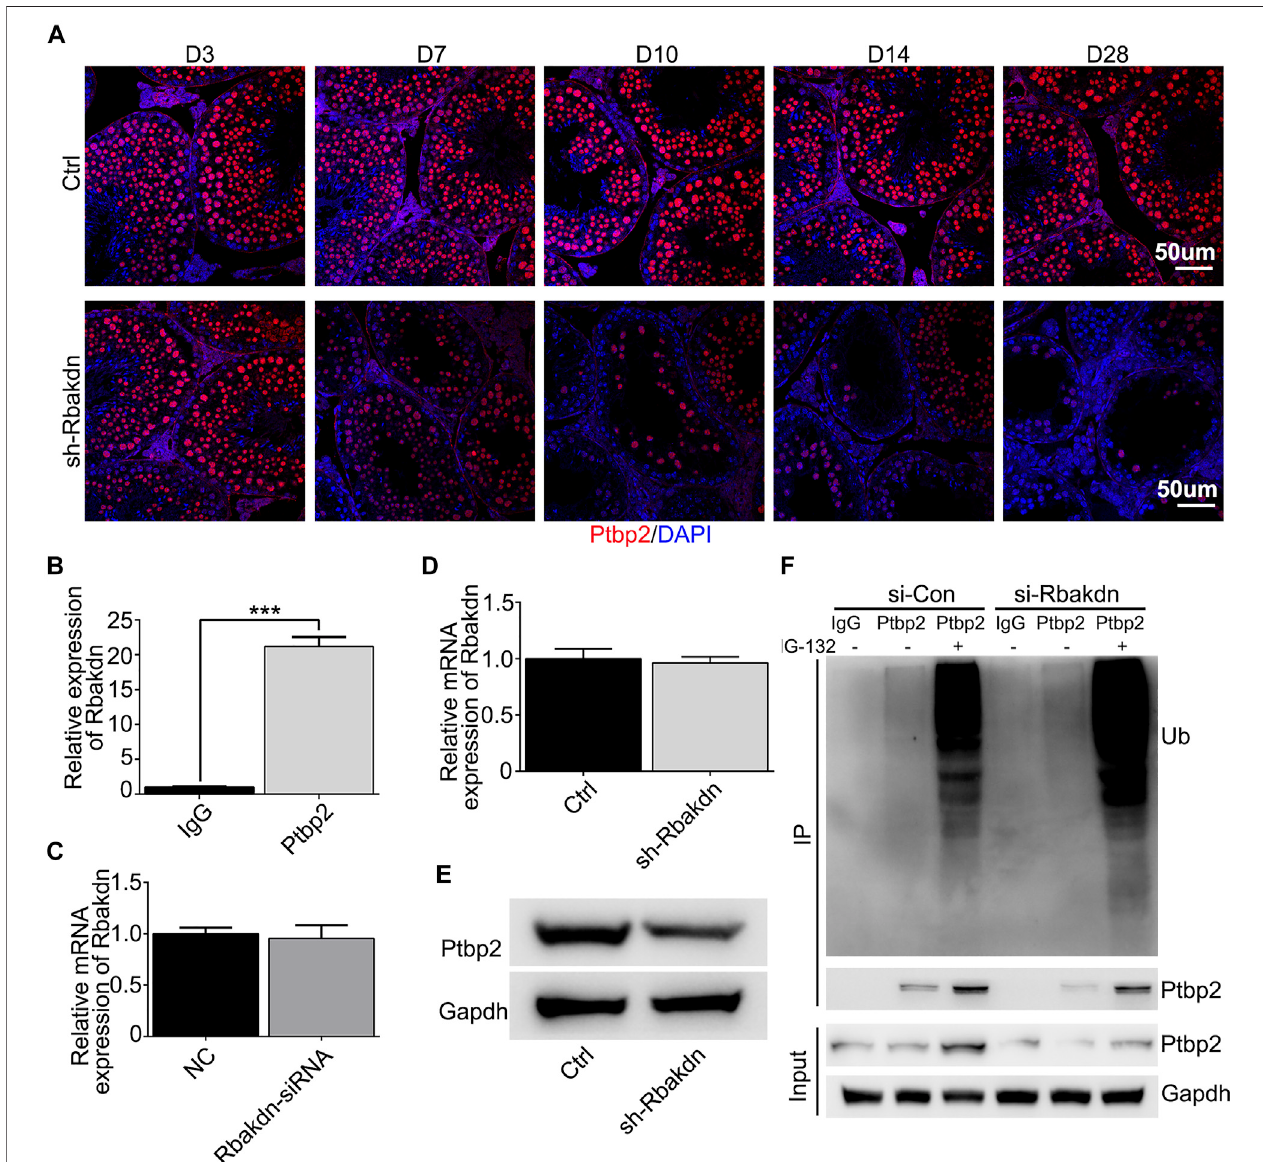
FIGURE 5 | Knockdown of Rbakdn reduces the expression of the RNA binding protein Ptbp2. (A) Ptbp2 expression in the testes after Rbakdn knockdown. Blue: DAPI; Red: Ptbp2. (B) Ptbp2 expression after RNA-IP in GC-2spd cells. (C) Ptbp2 mRNA after Rbakdn knockdown by lentivirus in GC-2spd cells. (D) Ptbp2 mRNA expression afterRbakdnknockdown bylentivirusinGC-2spdcells. (E) Ptbp2proteinlevelafterRbakdnknockdownbysiRNAinGC-2spdcells. (F) Theubiquitinlevelof Ptbp2 after Rbakdn knockdown by siRNA in GC-2spd cells.